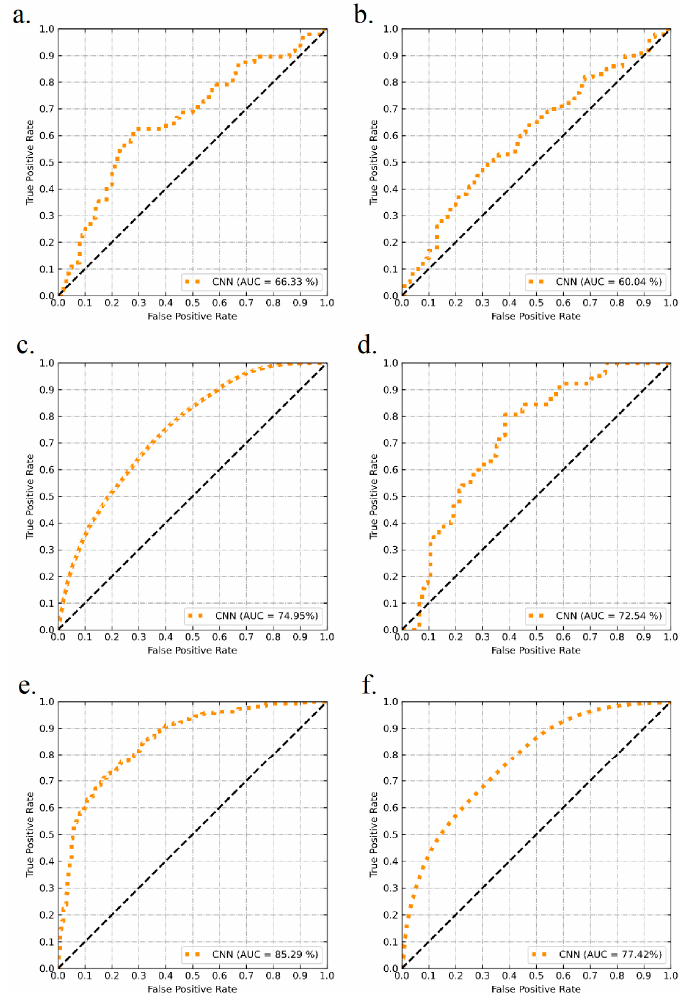
Figure 6. ROC for models with different window sizes; 48 × 48 windows ( a ), 32 × 32 windows ( b ), 16 × 16 windows ( c ), 8 × 8 windows ( d ), the optimal 16 × 16 windows only for large landslide body recognition ( e ) and the optimal 8 × 8 windows only for small landslide body recognition ( f ),